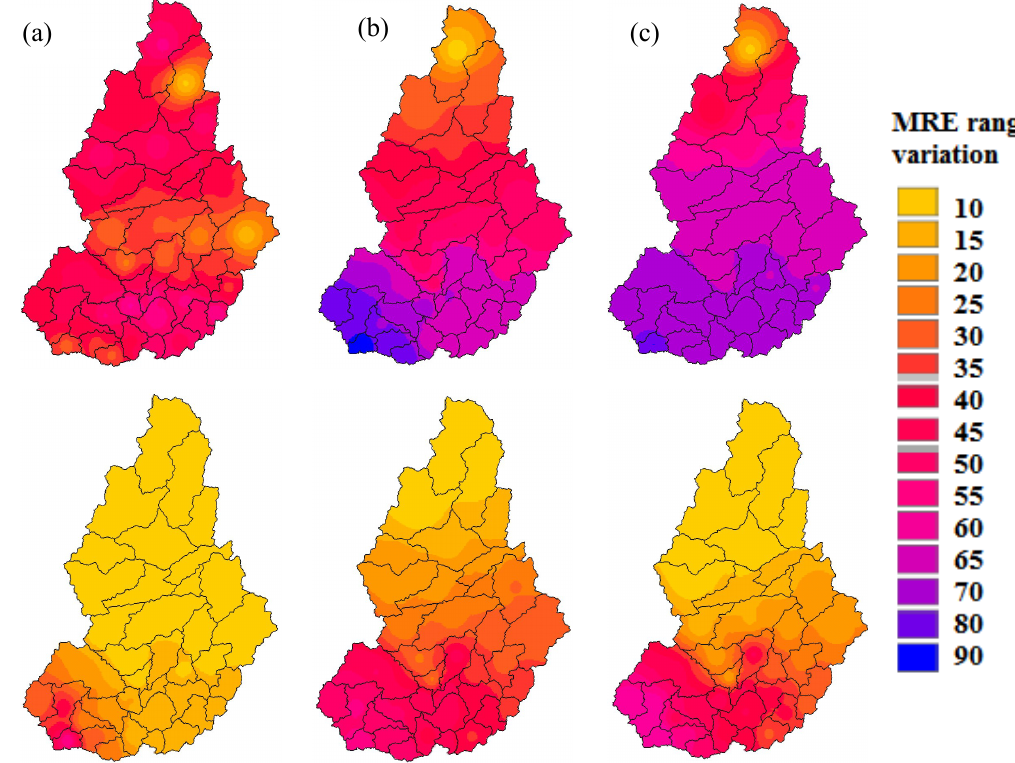
Figure 7. The comparison of the spatial distribution of the MRE in 38 sub-basins before (upper part) and after bias correction (down part) for the events in ( a ) 2002, ( b ) 2007 and ( c ) 2011. The performance of the SURR model in simulating the streamflow along with the SURR-WRF coupled model before and after bias correction in forecasting the streamflow at the Gunnam, Jeonkuk and Jeogseong stations in the 2002, 2007 and 2011 events are illustrated in Figure 8. The observed stream flow (black dashed curve), the forecast stream flow using WRF data (blue curve), the forecast stream flow using bias-corrected WRF data (green curve) and the simulated streamflow (red curve) are presented in Figure 8. The Jeonkuk station has no observation data for the 2002 event.